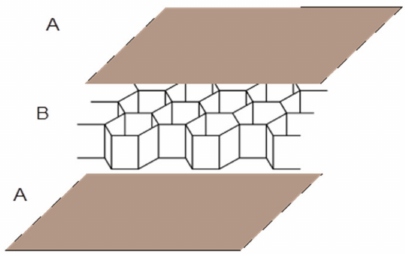
Figure 1. Construction of honeycomb paperboard